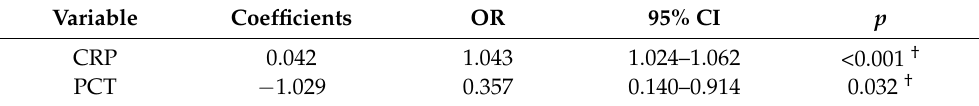
Table 2. Multiple logistic regression analysis of biomarkers used for distinguishing